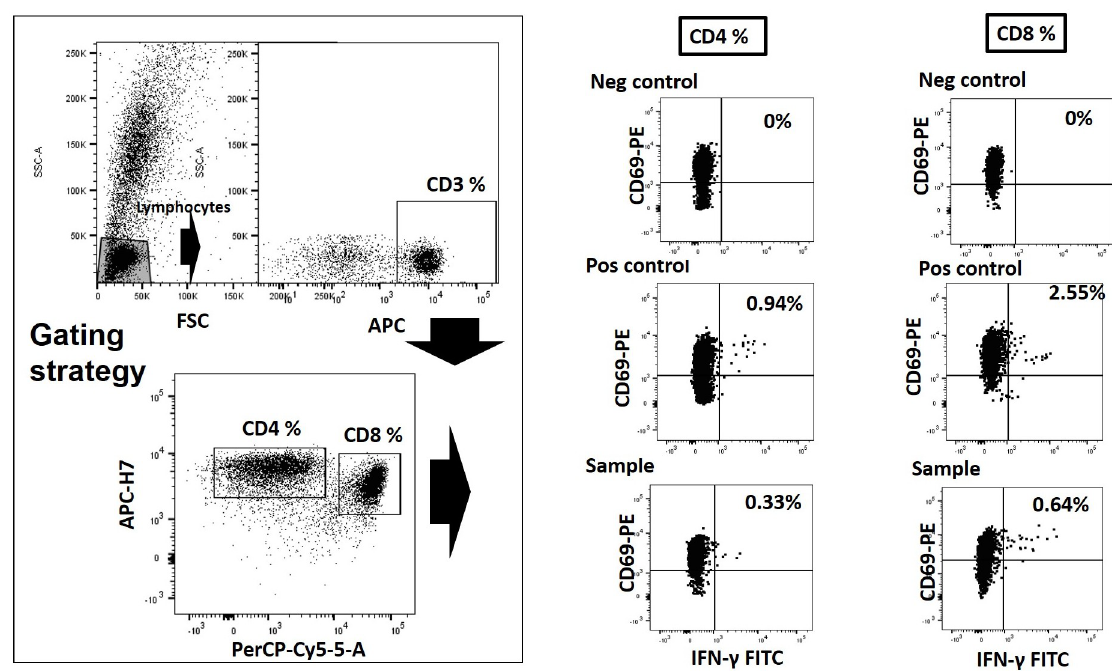
Fig 1. Gating strategy for the enumeration of CMV-specific IFN- γ producing CD4+ and CD8+ T cells by Intracellular Cytokine Staining (ICS). Total Lymphocyte/CD3+/CD8+ or Lymphocyte/CD3+/CD4+ events were gated and then analyzed for CD69+/IFN- γ production. Positive (Phytohemaglutinin) and negative controls (DMSO) were